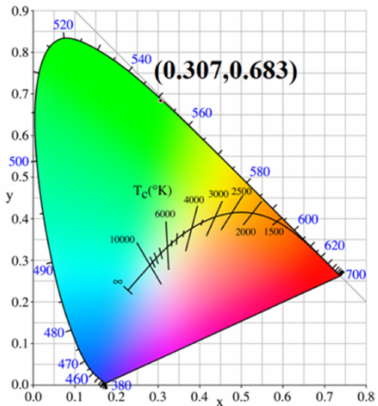
Figure 13. Color coordinates of (ZrO 2 ) 90 (Y 2 O 3 ) 9.50 (Ho 2 O 3 ) 0.50